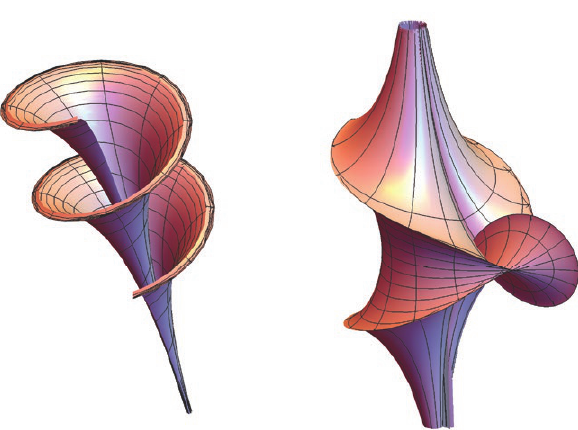
Figure 23. Some pseudospheres: (Left ) A cusp-free section of one member of Dini’ s surfaces. (Right) Kuen’s surface, including